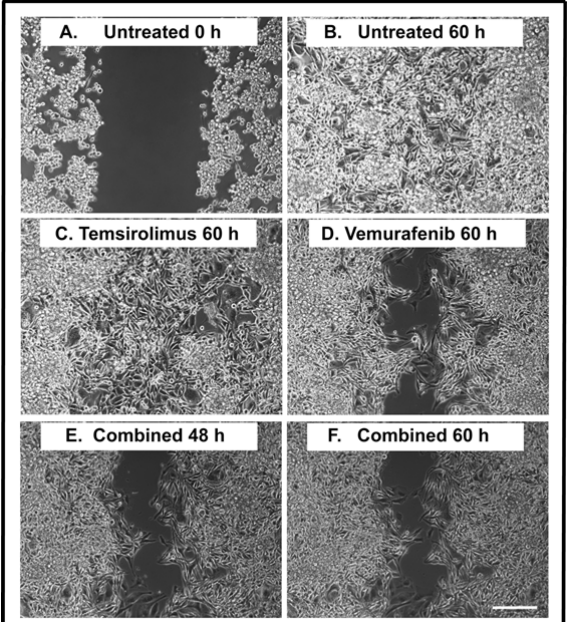
Figure 2. Wound healing assay of H1_DL2 melanoma brain metastasis cells after treatment with vemurafenib and temsirolimus. ( A ) Untreated H1_DL2 cells at 0 h; ( B ) Untreated cells 60 h after initiating a scratch wound; ( C ) Representative picture 60 h after initiating a scratch wound and starting the treatment with 5 µ M of temsirolimus; ( D ) Representative picture 60 h after initiating a scratch wound and starting the treatment with 5 µ M of vemurafenib; ( E ) Representative picture 48 h after initiating a scratch wound and starting combined treatment (5 µ M temsirolimus and 5 µ M vemurafenib); and ( F ) Representative picture 60 h after initiating a scratch wound and starting combined treatment (5 µ M temsirolimus and 5 µ M vemurafenib). Scale bar = 200 µ